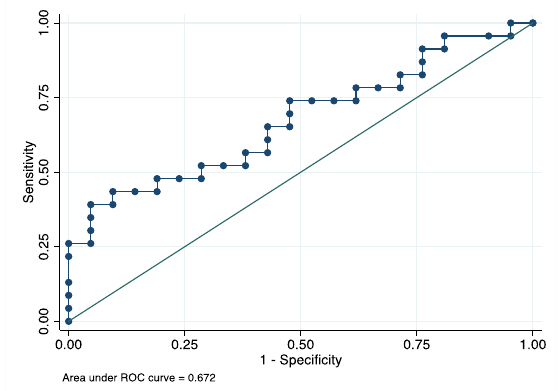
Figure 4. Receiver operating characteristic (ROC) curves for MMP8 to evaluate a biomarker’s ability for moderate/severe AD status.